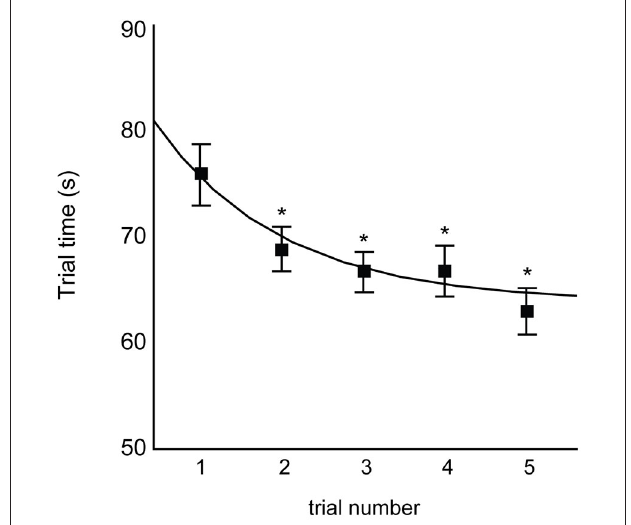
FIGURE 2 | Mean trial times for the first five trials of skill training . Trials 2, 3, 4, and 5 were all significantly faster than trial 1 (Dunnett’s test ∗ p < 0.05). Curve indicates exponential decay fit across all participants ( y = 65.98 + 22.82 e − 0.91x